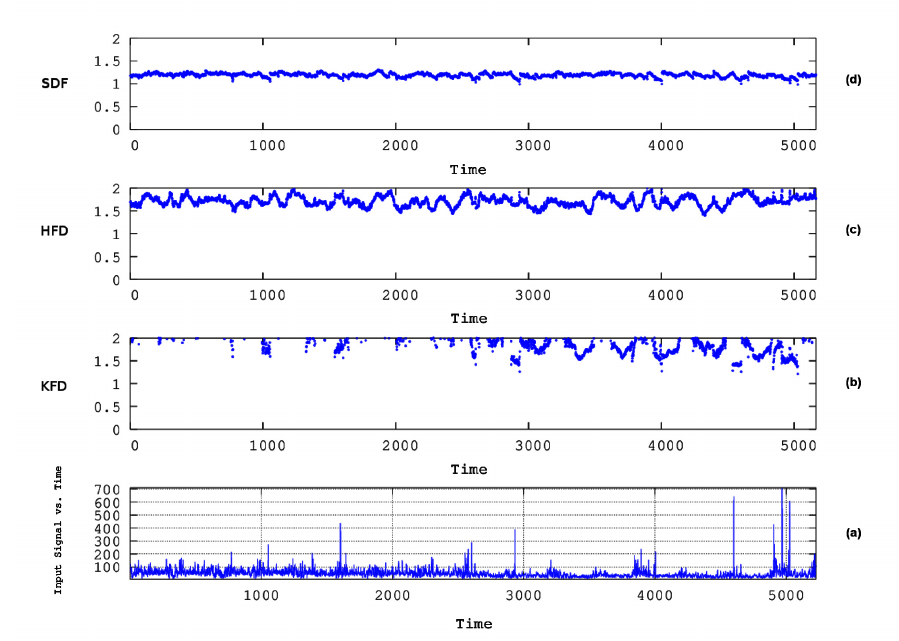
Figure 3. Time evolution of the fractal dimension of the PM 10 time series recorded by the LYK station between the years 2001–2016. From bottom to top: ( a ) time series (mean daily values/concentrations) and fractal dimensions according to the algorithms of ( b ) KFD ( c ) HFD, and ( d ) SFD. PM 10 concentration in µ g/m 3 . Time is in days (or sample number). Each window of analysis contains 64